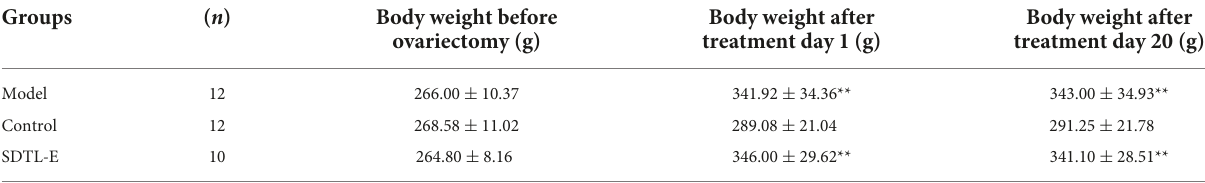
TABLE 2 Body weight of rats before ovariectomy and after treatment.